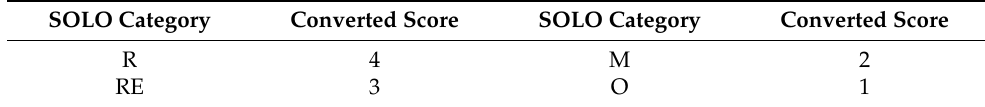
Table 2. Numeric SOLO categories of program comprehension.